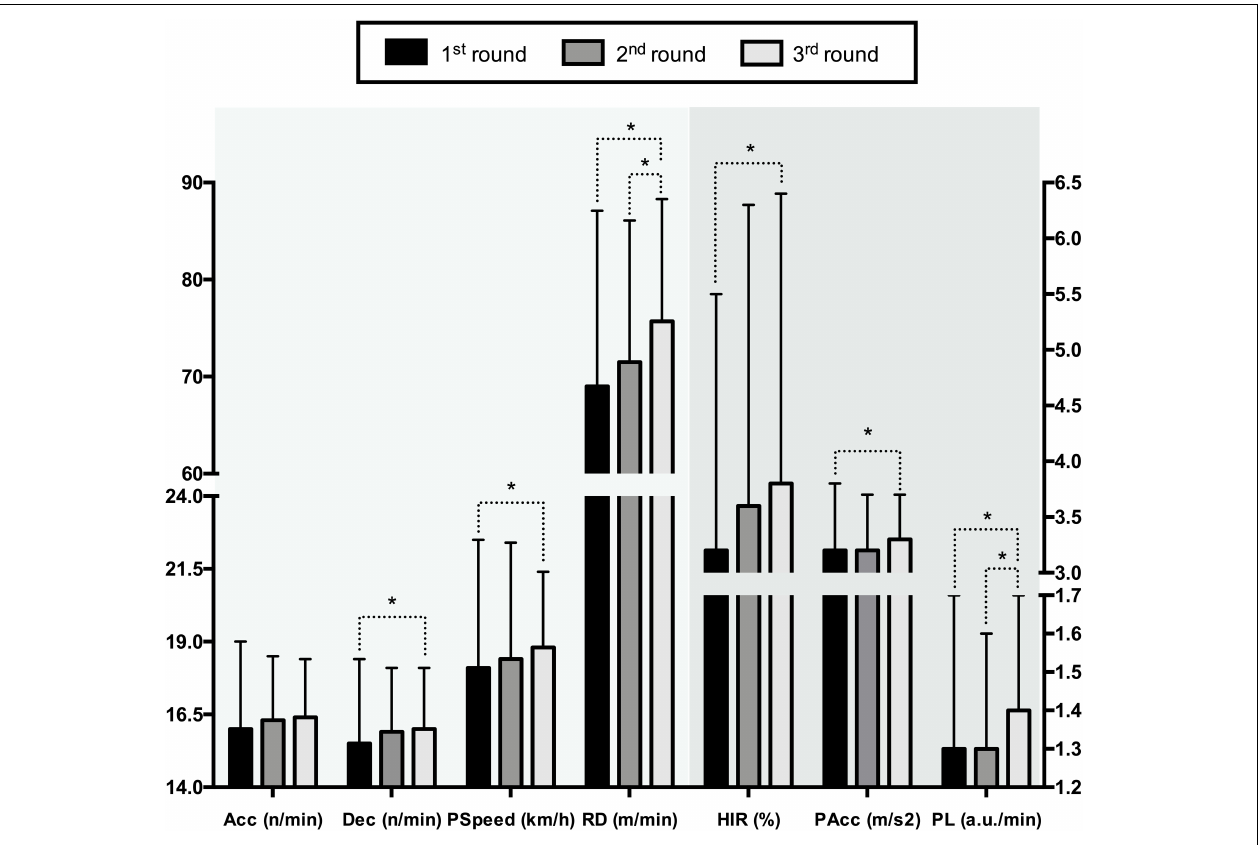
FIGURE 4 | Consecutive match demands variation throughout the tournament. ∗ p <